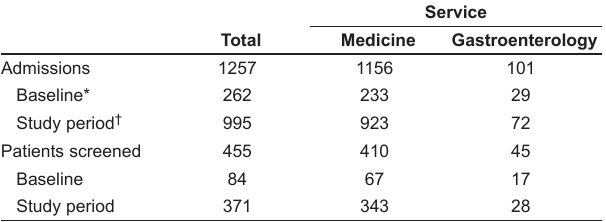
TAble 1 Admission and screening data according to service during baseline data collection and study period at Vancouver